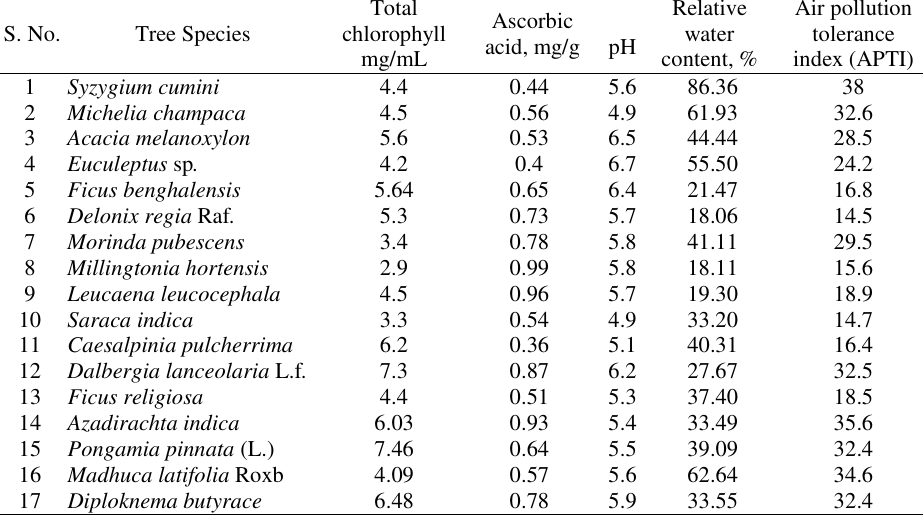
Table 4. Air pollution tolerance index (APTI) for tree species Jigini industrial area of south Bengaluru S.